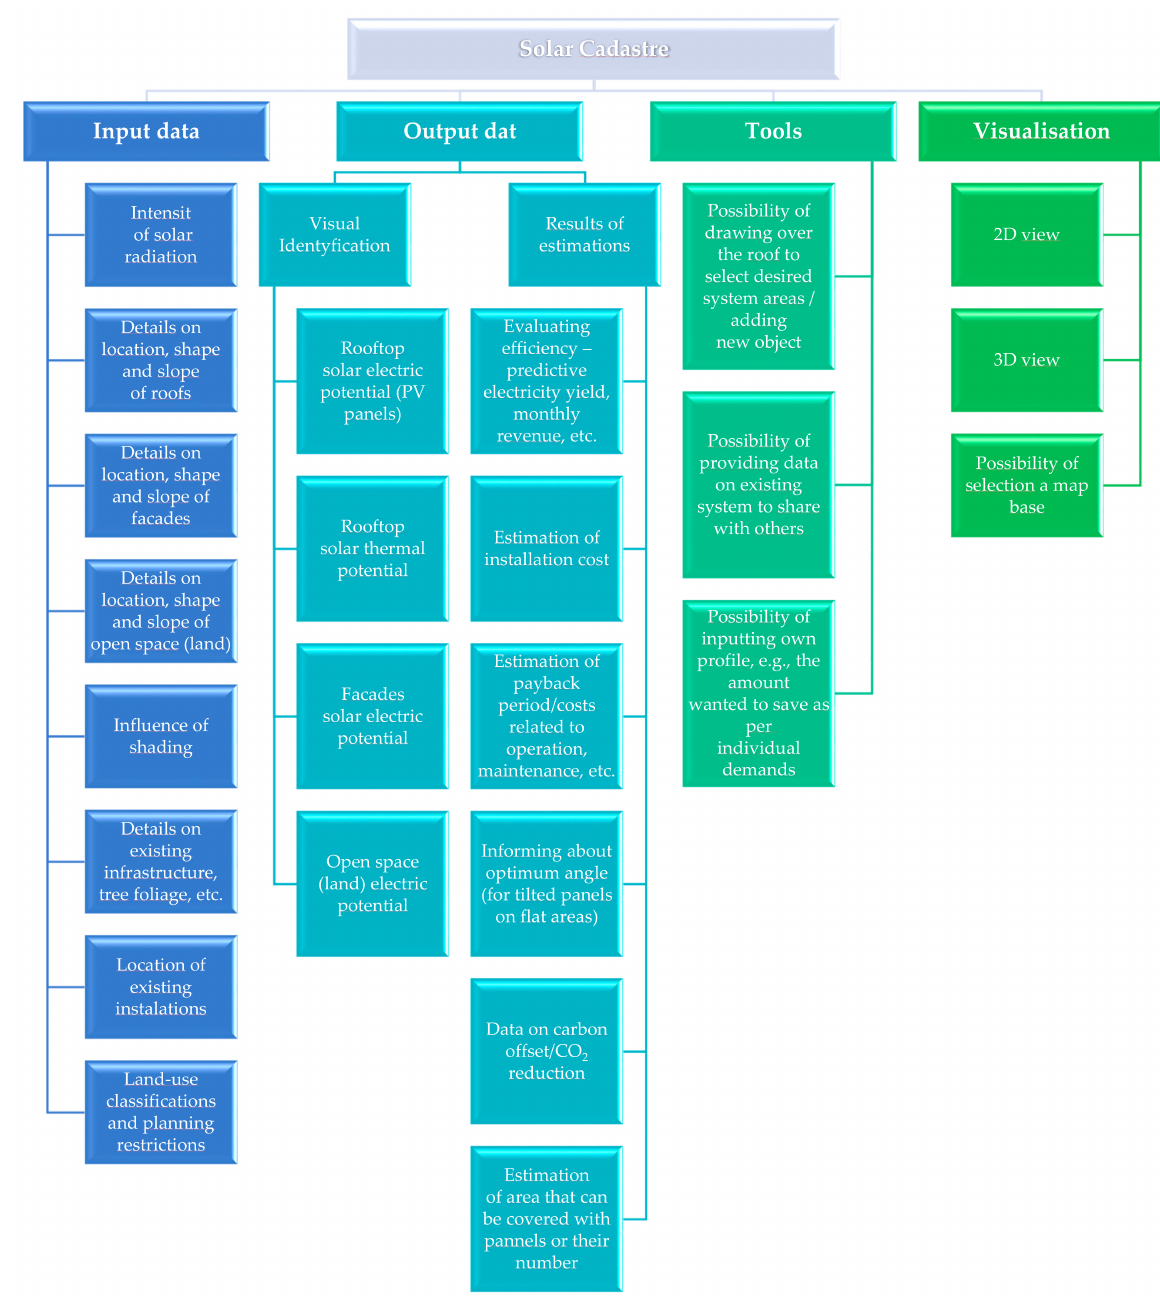
Figure 15. Scheme of the solar cadastre. Source: own